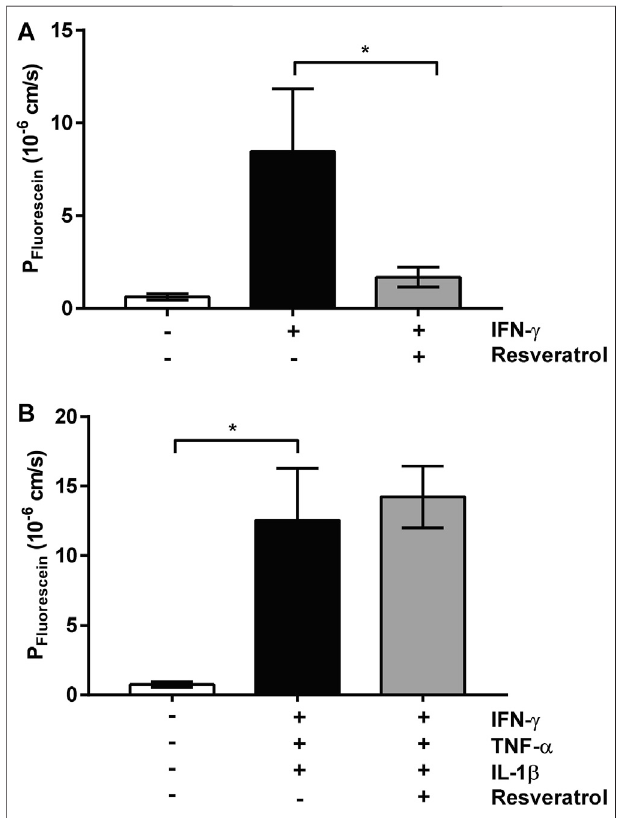
FIGURE 6 | In vitro stimulation model with cytokines and resveratrol. Cytokine-induced barrier dysfunction from the subepithelial compartment of HT-29/B6-GR/MR cell monolayers. Resveratrol treatment was performed from the apical side 2 h before cytokine addition. Fluorescein permeability displays barrier-breaking effects for (A) 50 ng/ml IFN- γ and (B) high-dose cytokine cocktail containing 100 U/mL TNF- α , and 100 ng/ml IL- 1 β , 50 ng/ml IFN- γ ( n (cid:2) 3 – 8, * p < 0.05, *** p < 0.001, one-way ANOVA with Bonferroni